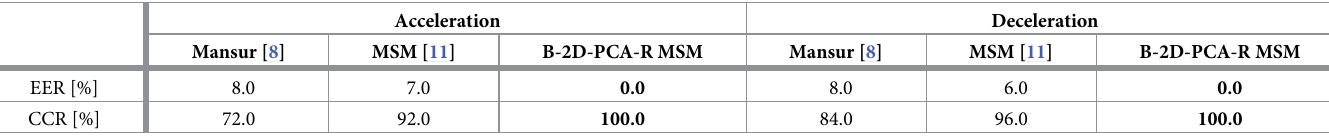
Table 7. EER and CCR of Mansur’s method [8], MSM-based method [11] and the B-2D-PCA-R MSM, for dataset 2.